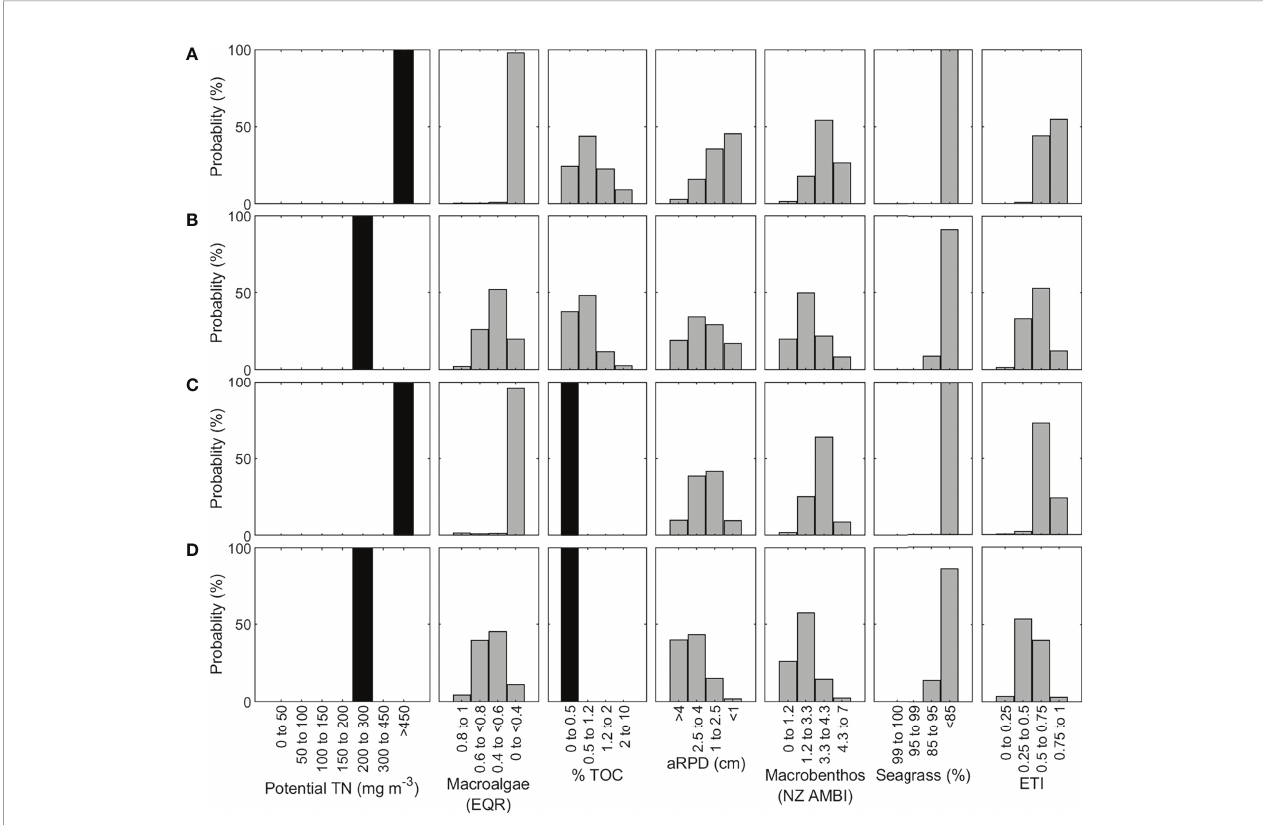
FIGURE 7 | Avon Heathcote Estuary ETI Tool 3 BBN results for (A) pre-wastewater diversion, (B) post-wastewater diversion, (C) pre-wastewater diversion with observed % TOC, and (D) post-wastewater diversion with observed % TOC. Black bars indicate where values have been input for each scenario, and grey bars are the distributions calculated by the